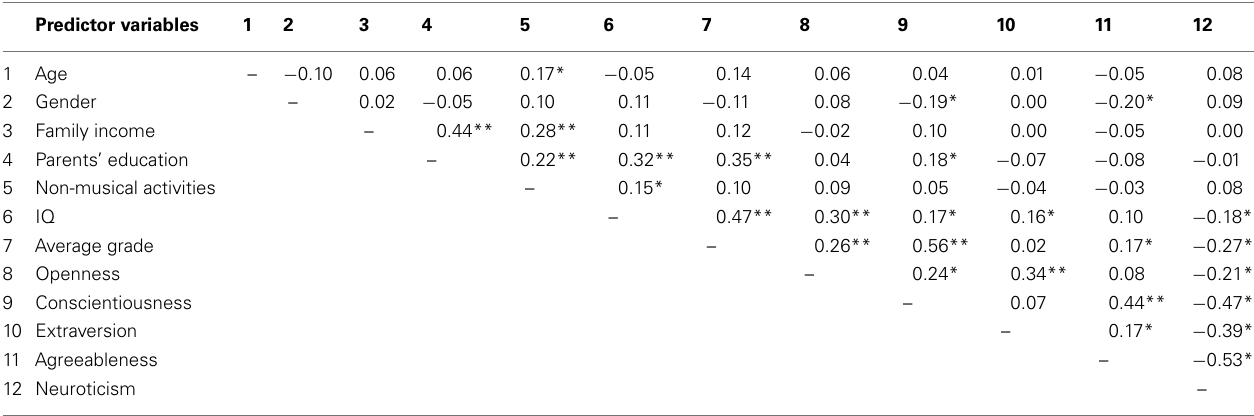
Table 3 | Correlations among predictor variables in study 2